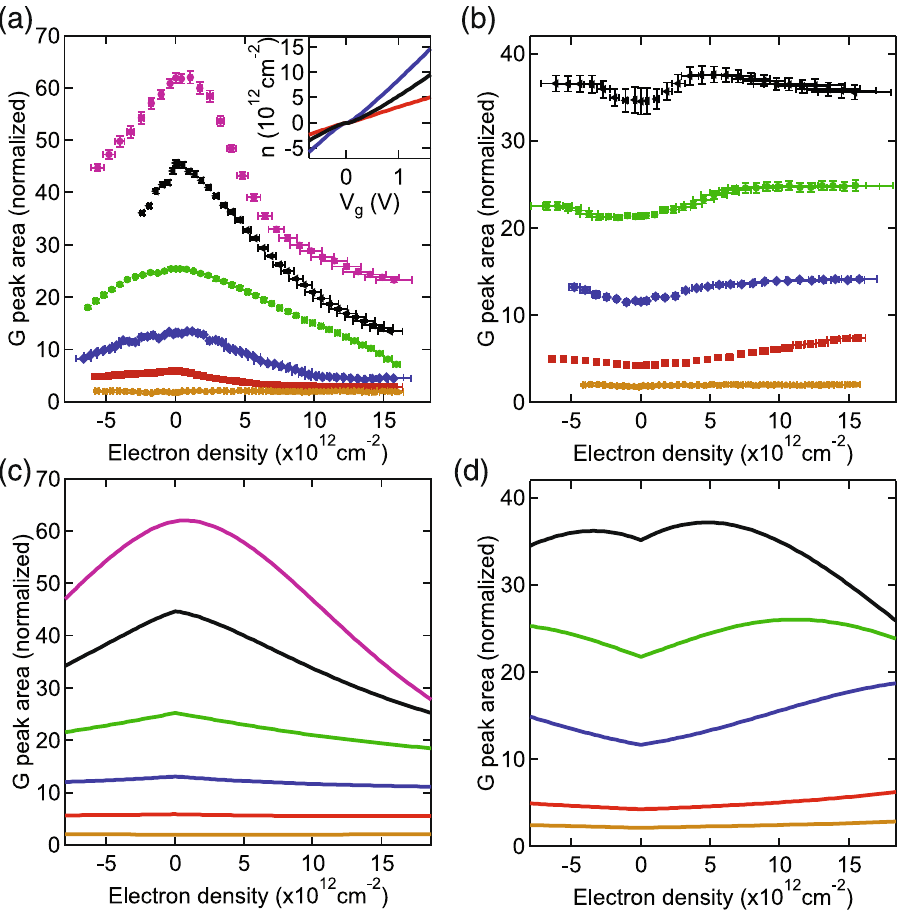
Figure 3. ( a ) Raman G peak area variation with total charge density for the critical and smaller twist angles. Purple: 12.6°, black: 12.1°, green: 11.6°, blue: 11.1°, red: 10.4°, orange: smaller than 3°. Inset is the calculation of bottom (red), top (black) and total (blue) charge densities for the tBLG corresponding to the blue curve in the main figure. ( b ) Raman G peak area variation with total charge density for twist angles larger than the critical angle. Black: 13.4°, green: 13.7°, blue: 14.1°, red: 15.1°, orange: bigger than 16°. The uncertainty in the angles is 0.1° due to the uncertainty of the G peak area. The error bars in electron density are from the uncertainty of the geometric capacitance. ( c ) and ( d ) Numerical calculation of Raman G peak area variation upon doping for the same twist angles as shown in ( a ) and ( b )